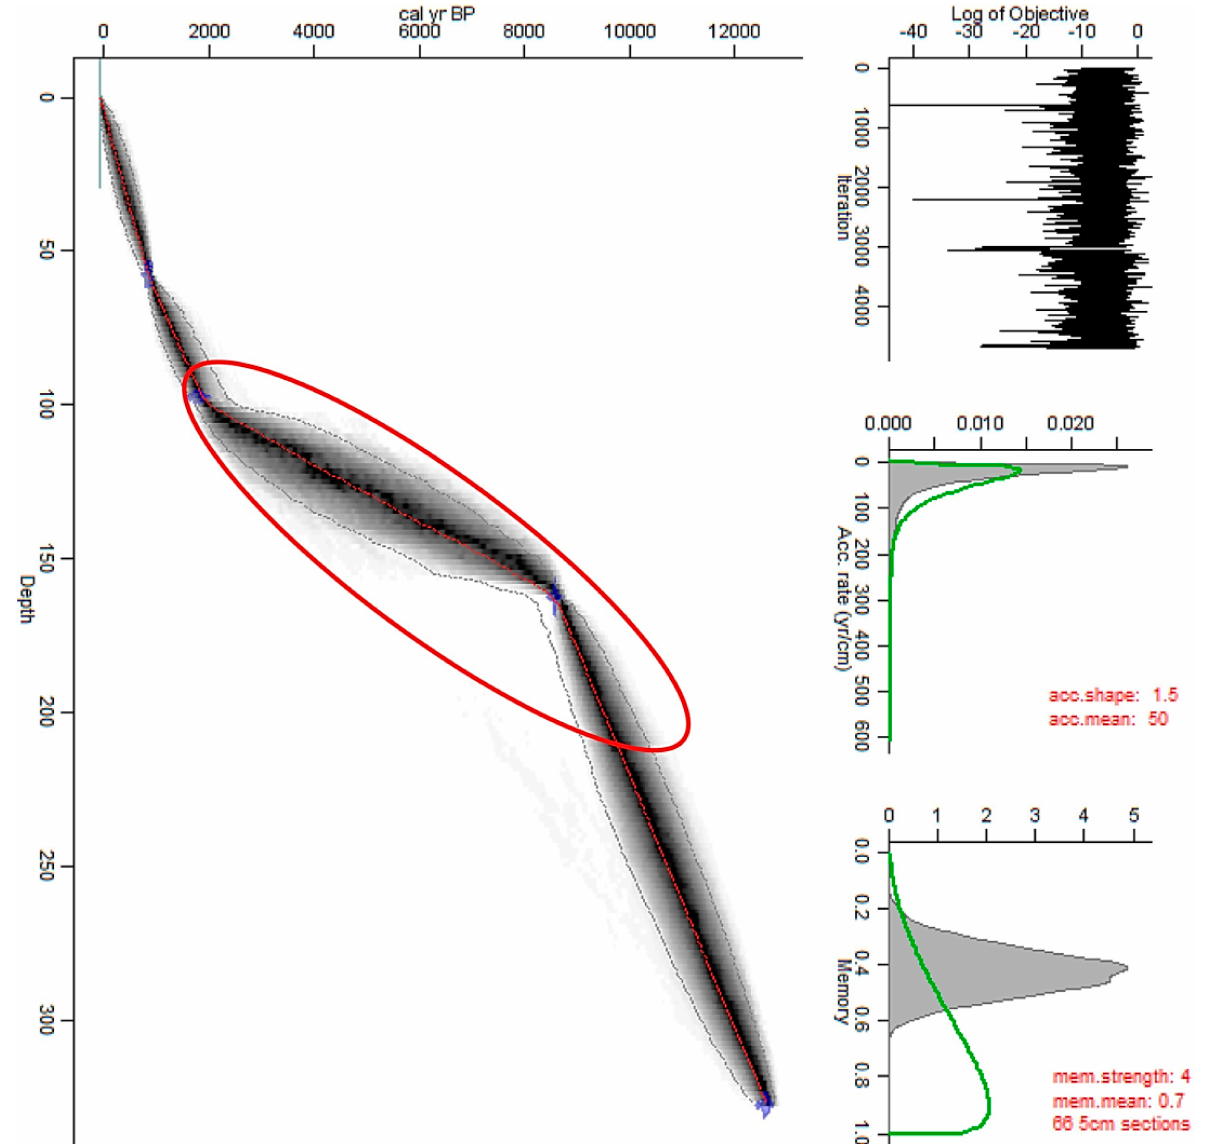
Figure 3. Age–depth model of the Blatuša mire. The red ellipsoid marks the period analysed in this article, from ~10,000 BP to the beginning of the Common Era (prepared by N. Piotrowska, modified by: D. Hruševar).